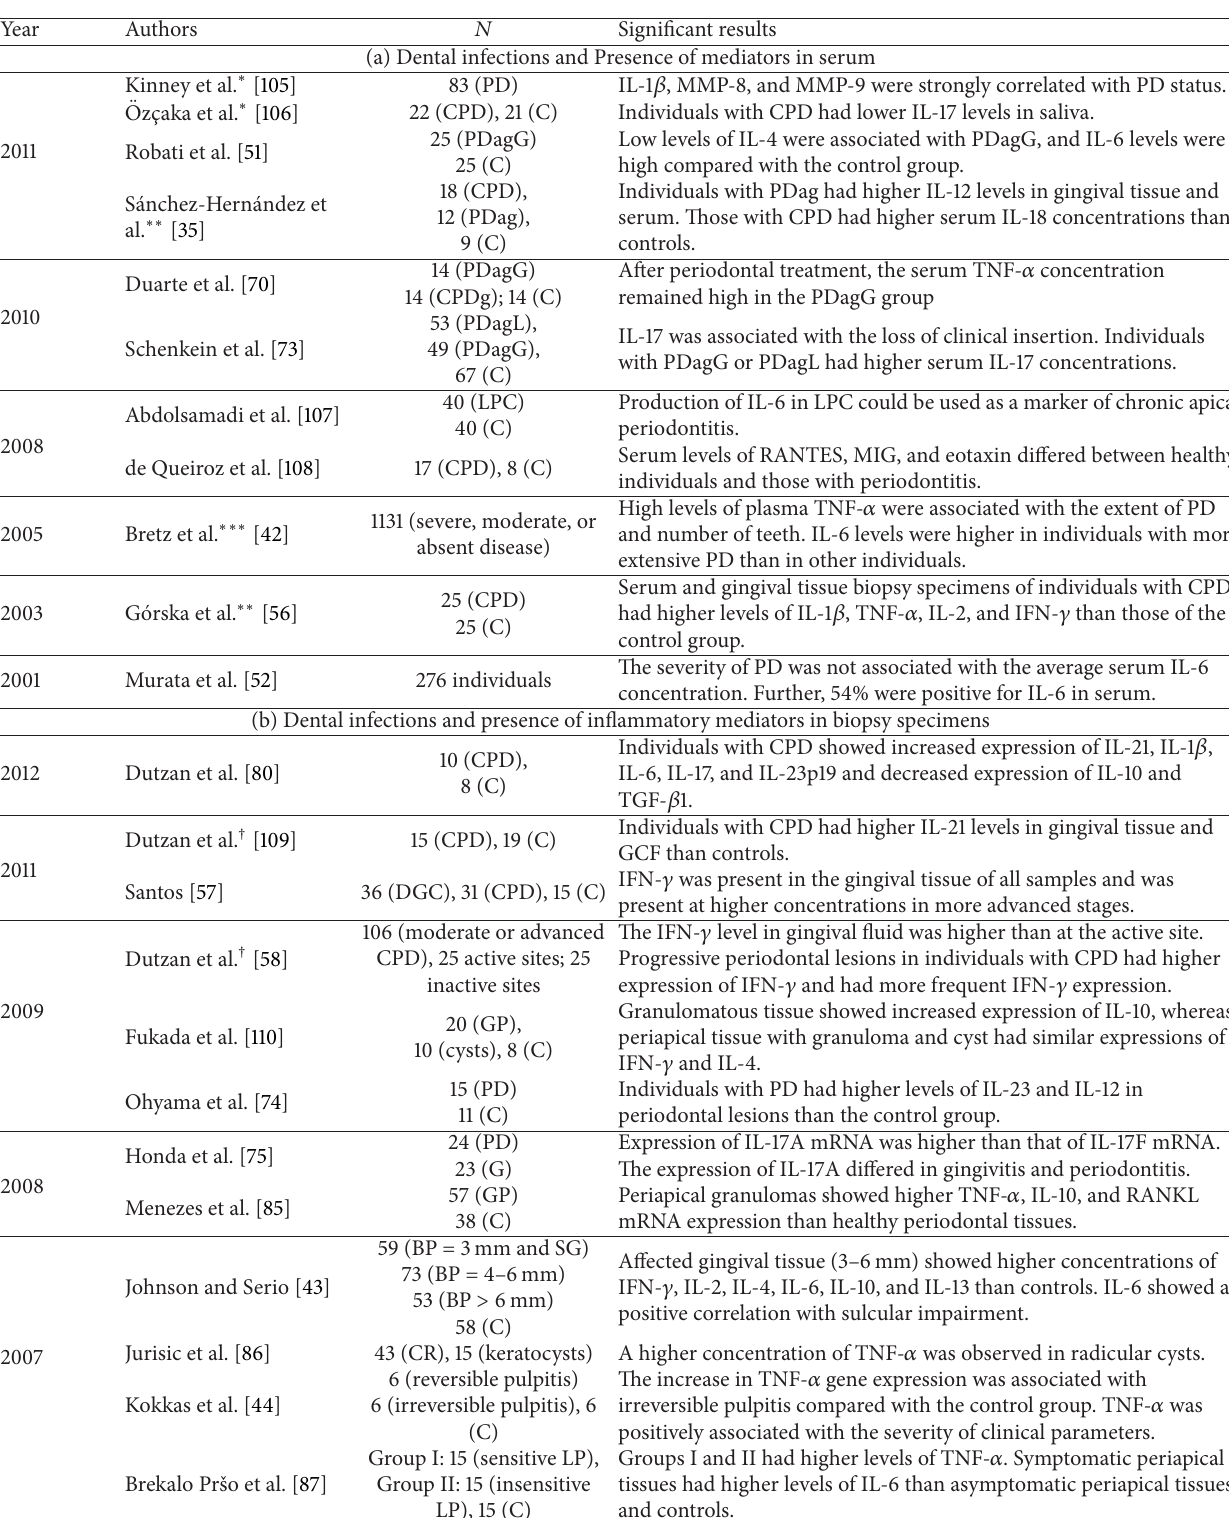
Table 2: Articles selected for the systematic review on dental infections and the presence of inflammatory mediators in serum (a), biopsy specimens (b), and gingival crevicular fluid (GCF) (c) according to the publication year, author, type of sample, and obtained